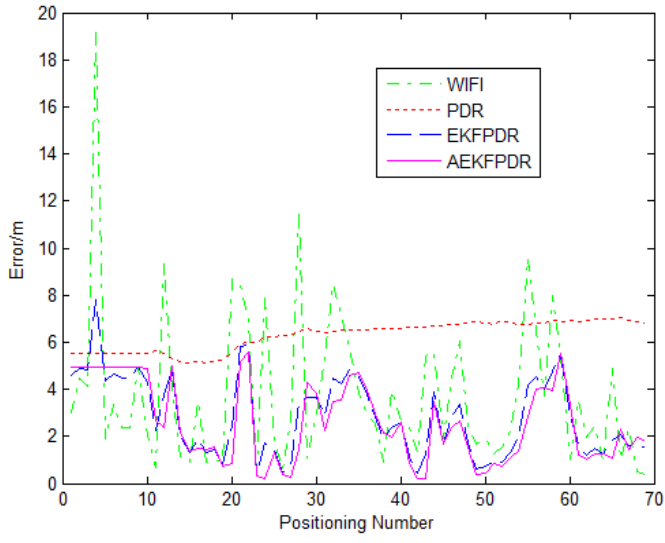
Figure 14. Error analysis of different indoor positioning methods. Table 3. Error analysis of different indoor positioning methods.